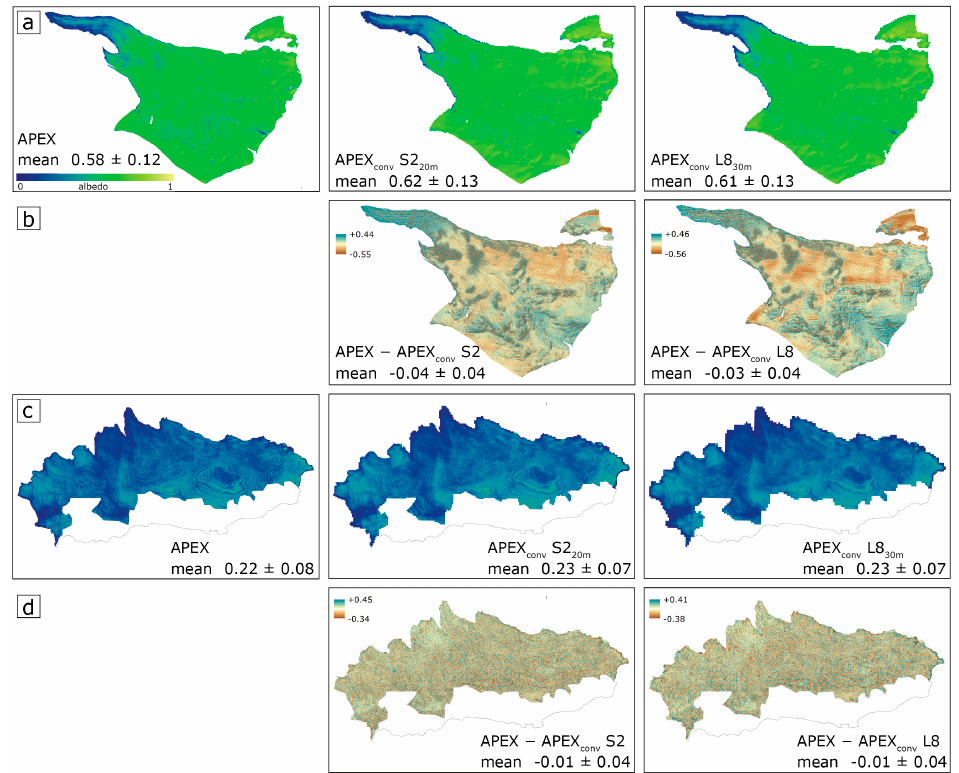
Figure 4. Albedo products derived using SBA ani from APEX data as well as the simulations thereof (APEX conv S2 20 m and APEX conv L8 30 m ) and differences between these data products are shown for Findelengletscher ( a,b ) and Glacier de la Plaine Morte ( c,d ).